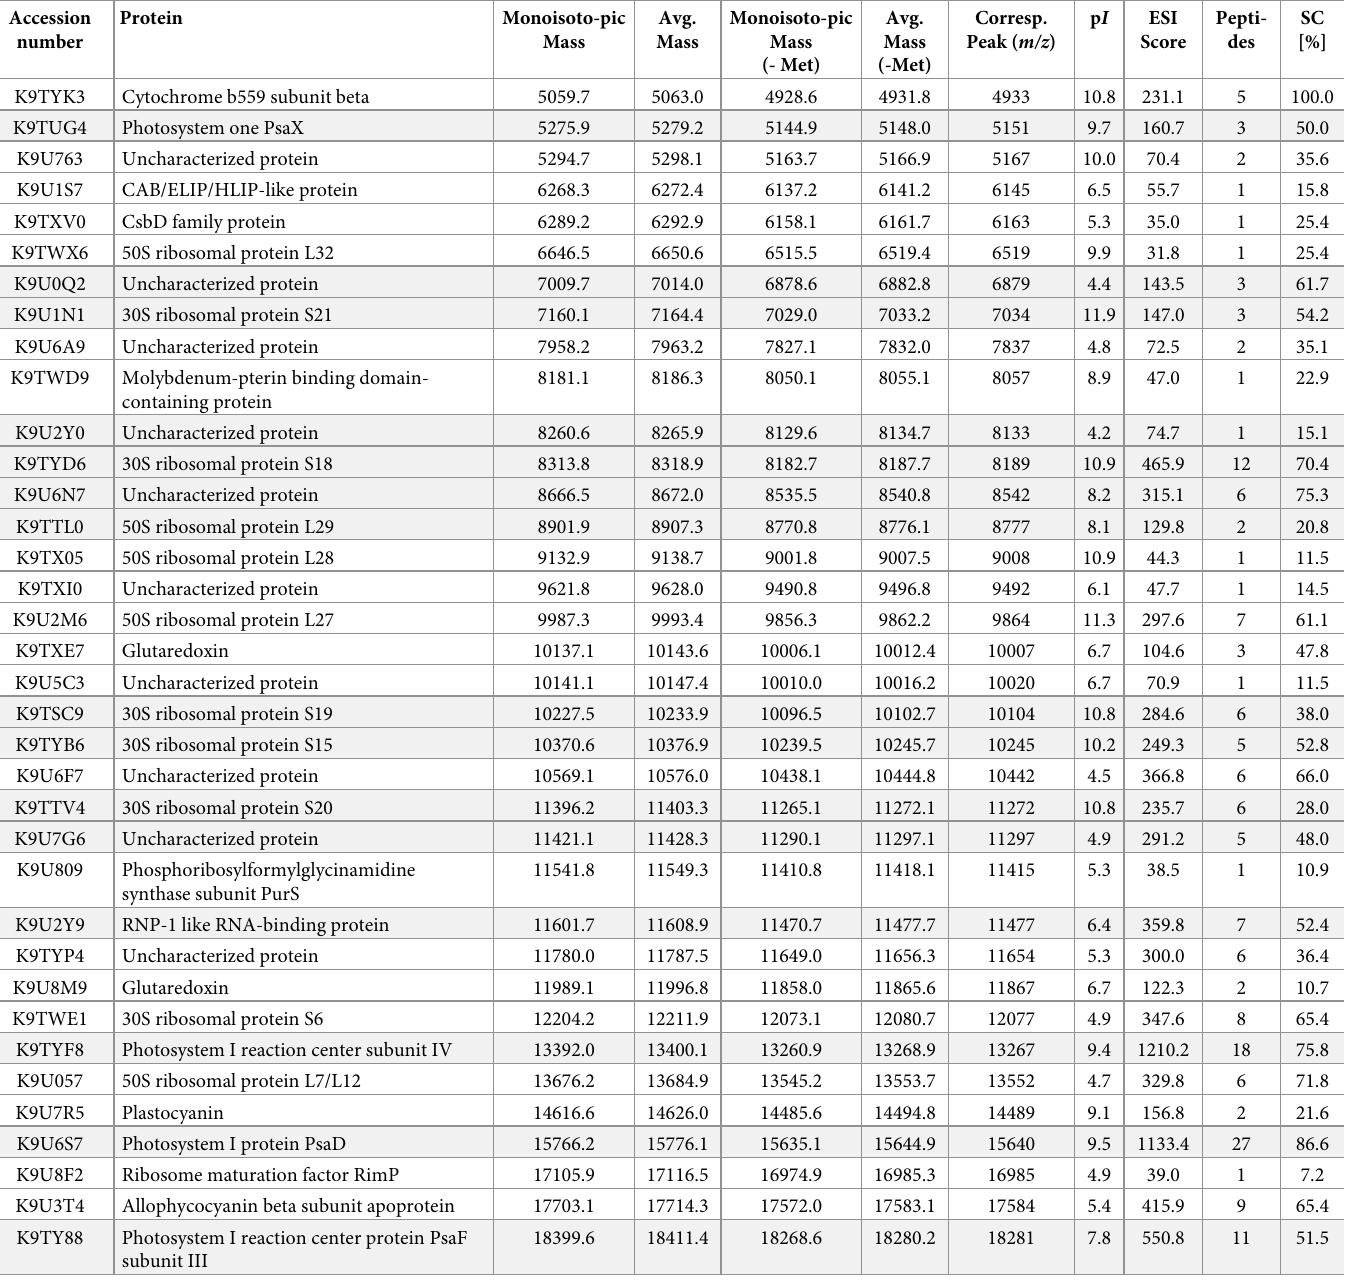
Table 2. Proteins assigned to the characteristic peaks in the profile IC MALDI mass spectrum of Chroococcidiopsis cubana (CCALA 043). Shadowing indicates which of these proteins were confirmed by both nanoLC-ESI-MS/MS and nanoLC-MALDI-MS/MS. The mass values are in Da, SC stands for sequence